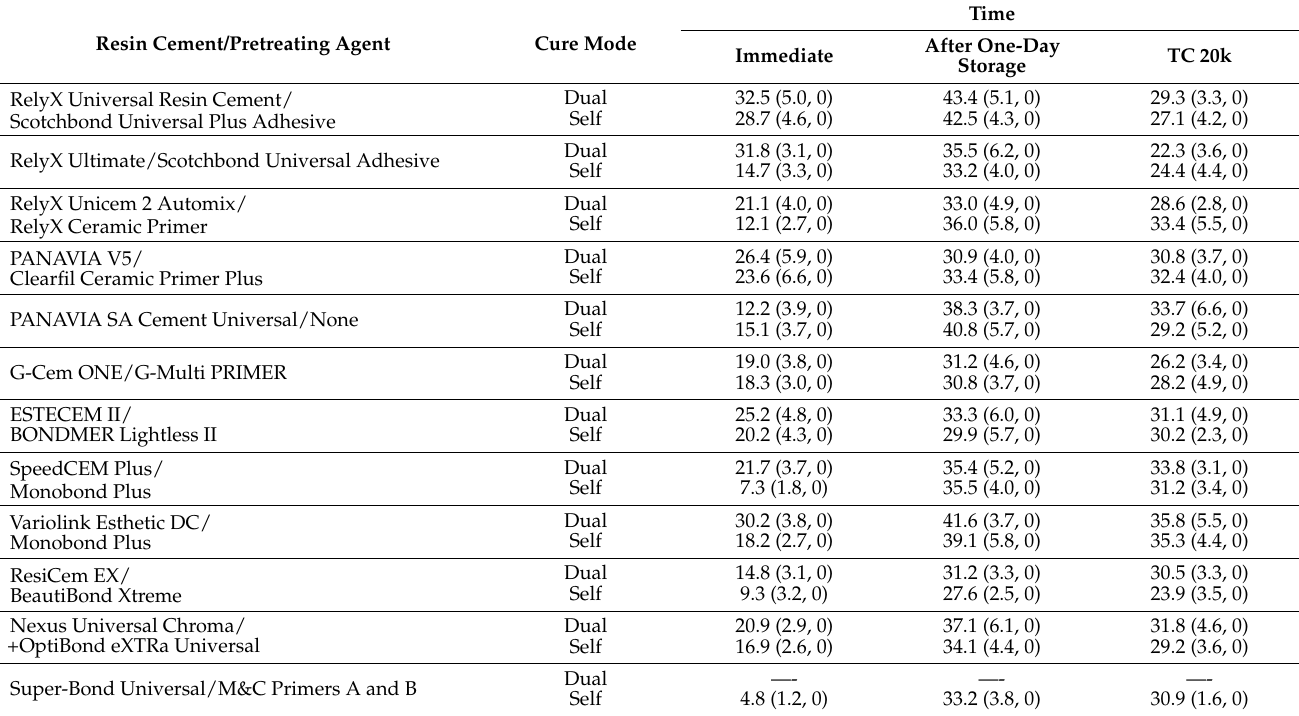
Table 3. Shear bond strength to LDS (e.max) of the adhesive resin cements (MPa, mean (S.D.), Adh.).